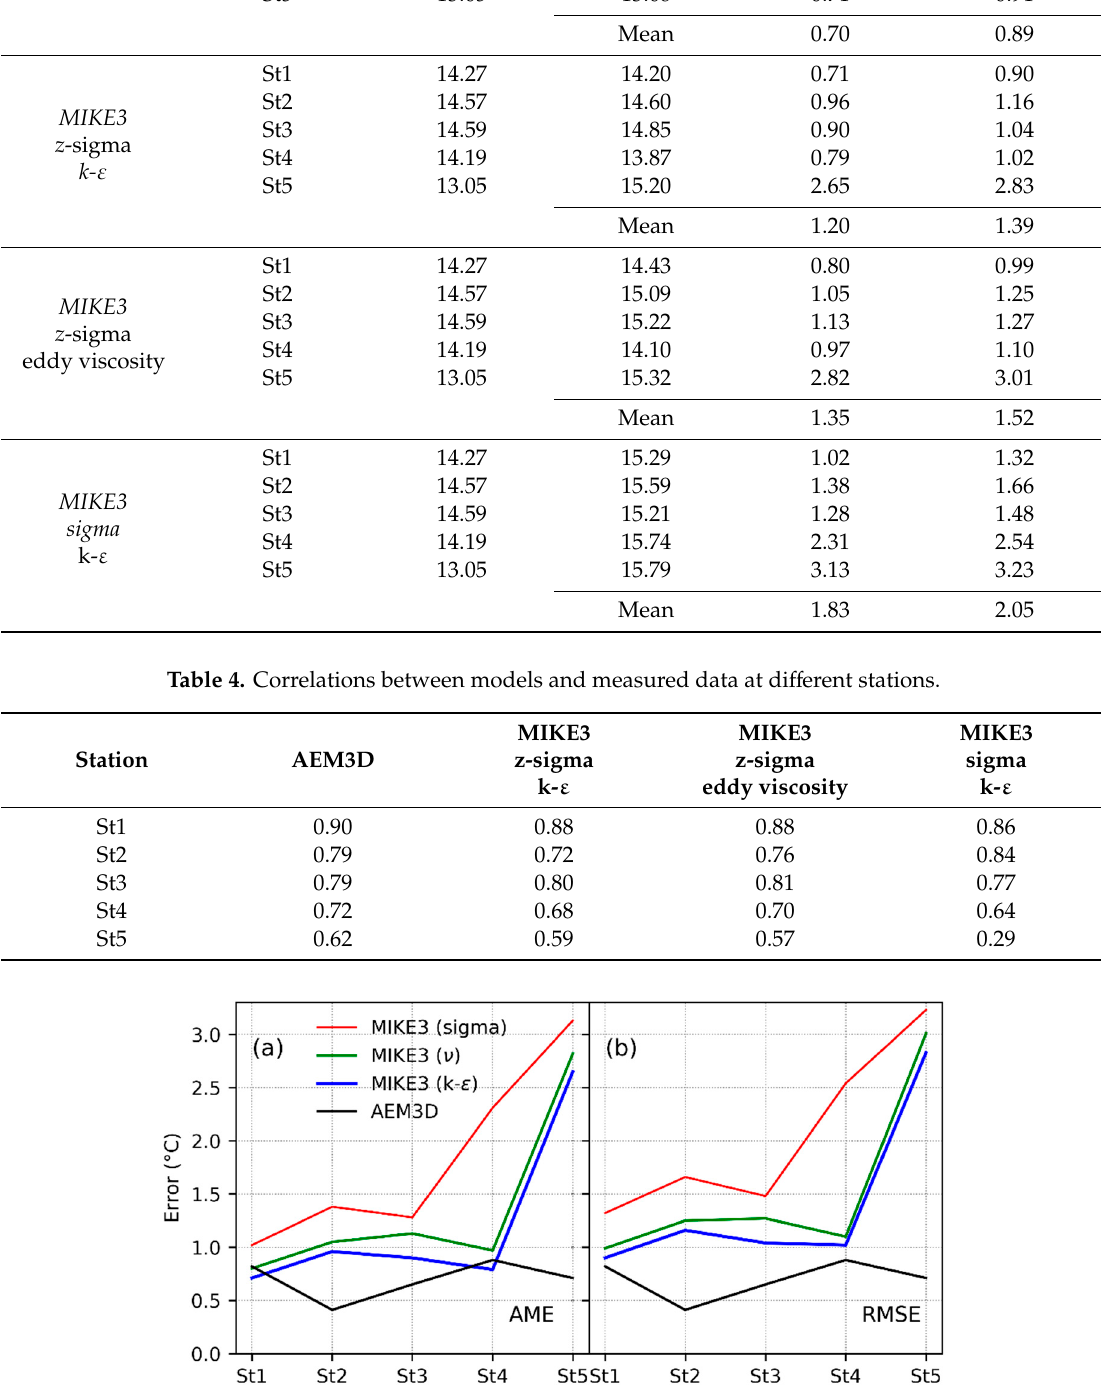
Figure 5. Observed and AEM3D- and MIKE3-simulated Maroon Reservoir water levels over the five-month simulation period. The color band illustrates the range of ±standard deviation of the observed water levels.